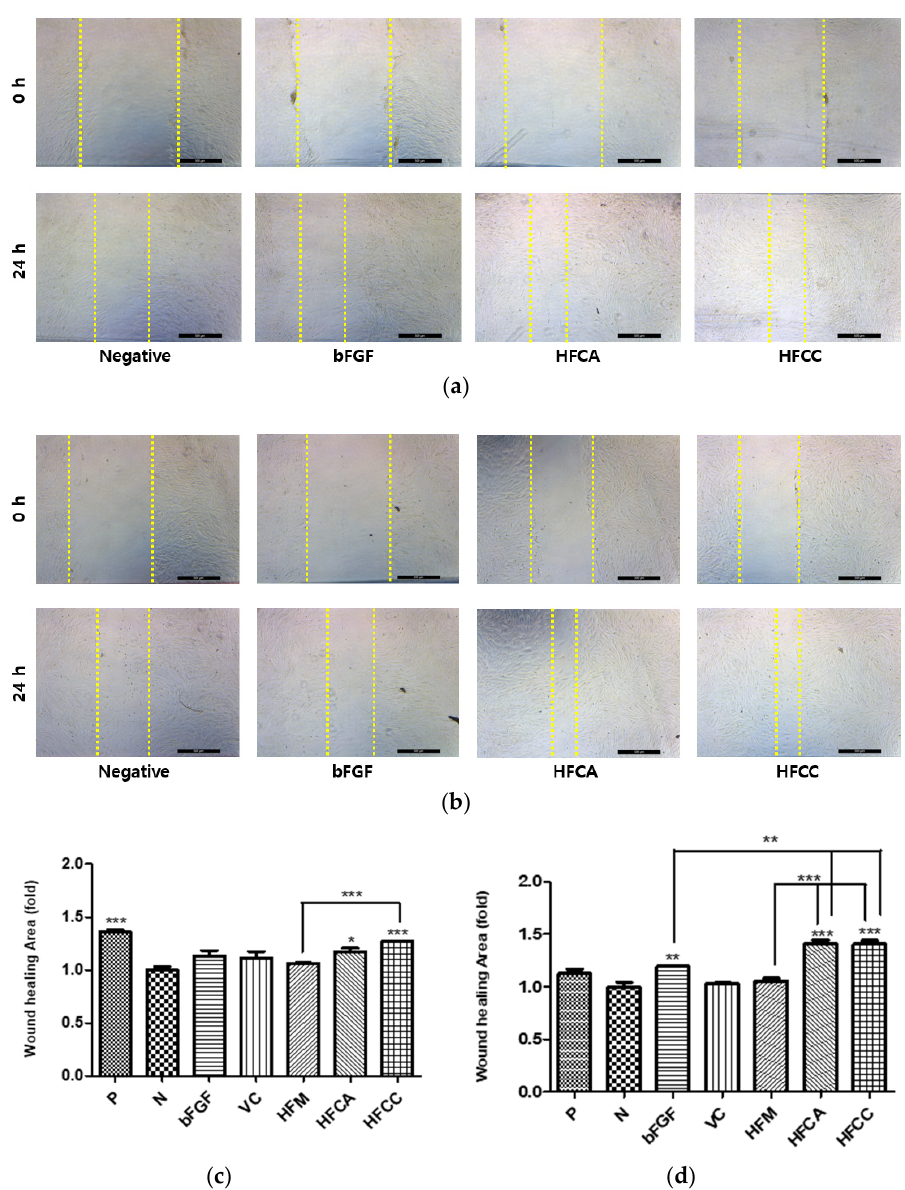
Figure 8. Representative bright ‐ field images of the HDF scratch wound assay ( a ) under normal conditions and ( b ) hyperglycemic conditions. Quantitative statistical analysis ( c ) under normal conditions and ( d ) hyperglycemic conditions after 24 h ( n = 3). Scale bars = 500 μ m. *** p < 0.001 , ** p < 0.01 , * p < 0.05.